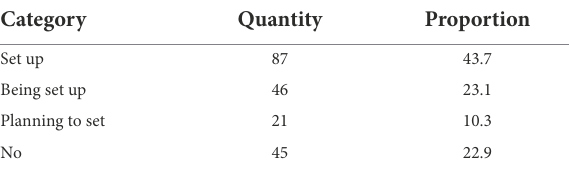
TABLE 4 Survey of professional settings and laboratory